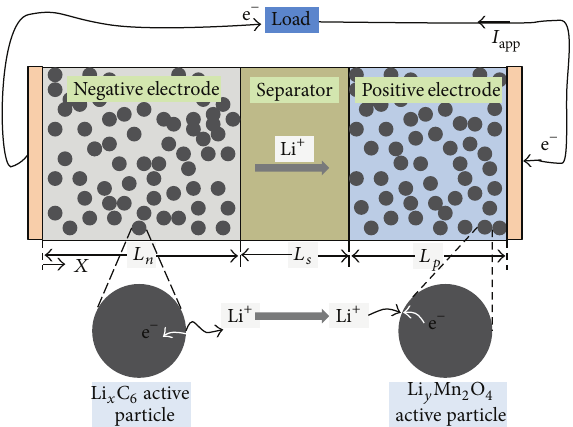
Figure 1: Schematic one-dimensional representation of a lithium ion battery with a single pair of electrodes under discharge condi-